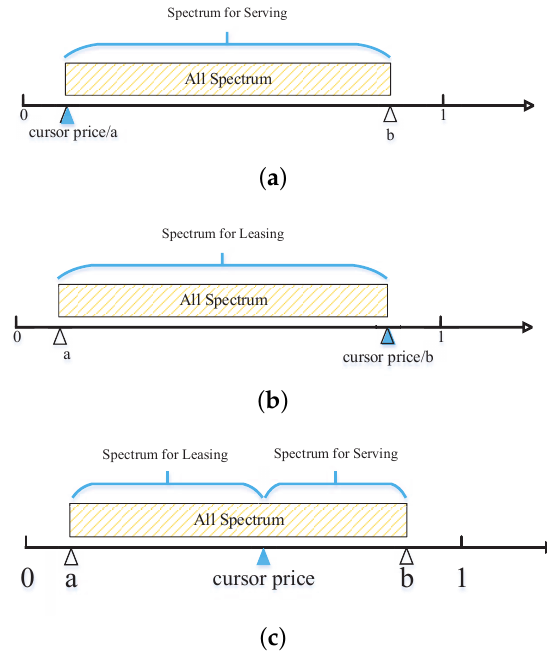
Figure 5. Three options for MBS: the effect of service price on spectrum allocation. ( a ) Option 1: sell all spectrum to MUEs; ( b ) Option 2: sell all spectrum to FBSs; ( c ) Option 3: sell part of the spectrum to MUEs and part to